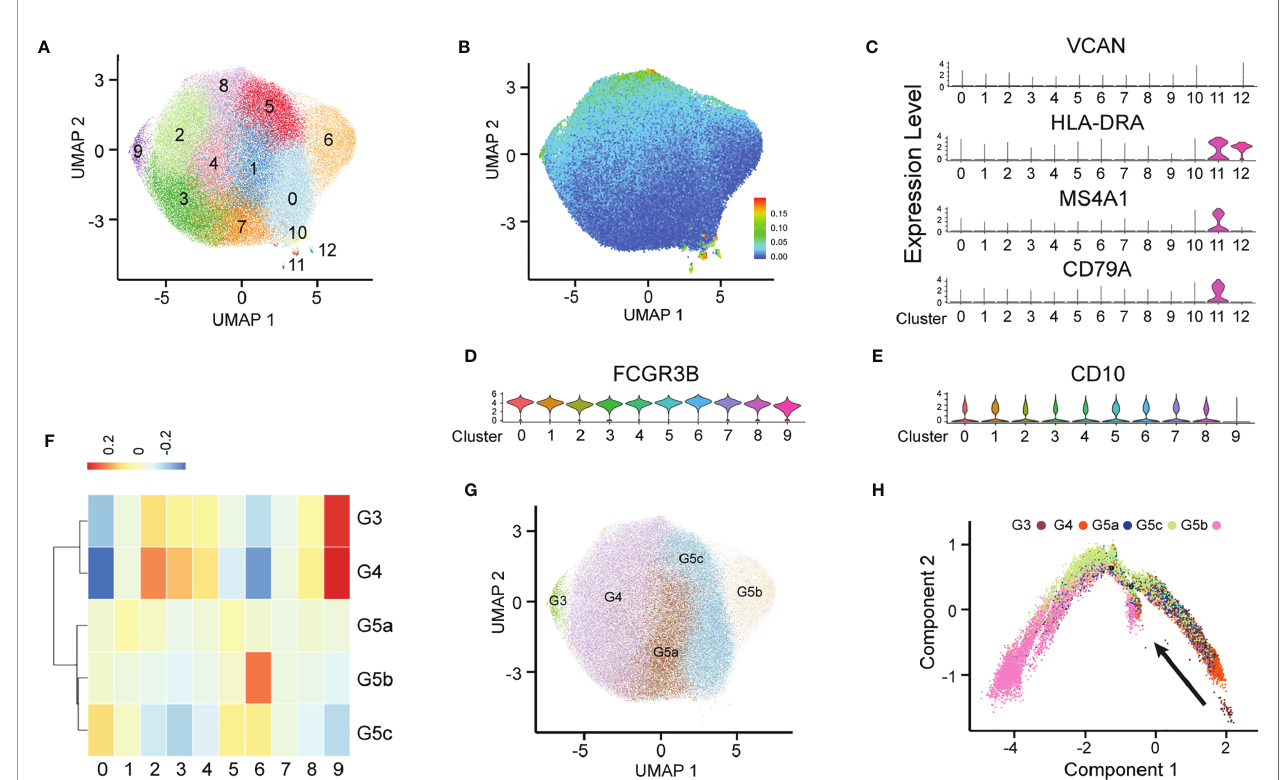
FIGURE 1 | Heterogeneity of peripheral blood PMNs in healthy and severely burned patients. (A) UMAP visualization of PMNs. (B) The expression of each neutrophil mitochondrial UMI projection on UMAP. (C – E) Violin plot of the genes VCAN, HLA-DRA, MS4A1, CD79A, FCGR3B and CD10 in 13 subgroups. (F) Correlation of scRNA-seq de fi ned neutrophil populations with the neutrophil subtypes reported by Xie et al. (G) Projection of new clustering results on UMAP. (H) Results of pseudo-time analysis. Each point represents a PMN. Cellular order was inferred from the expression of the most variable genes in all cells. Trajectory direction was determined by biological development